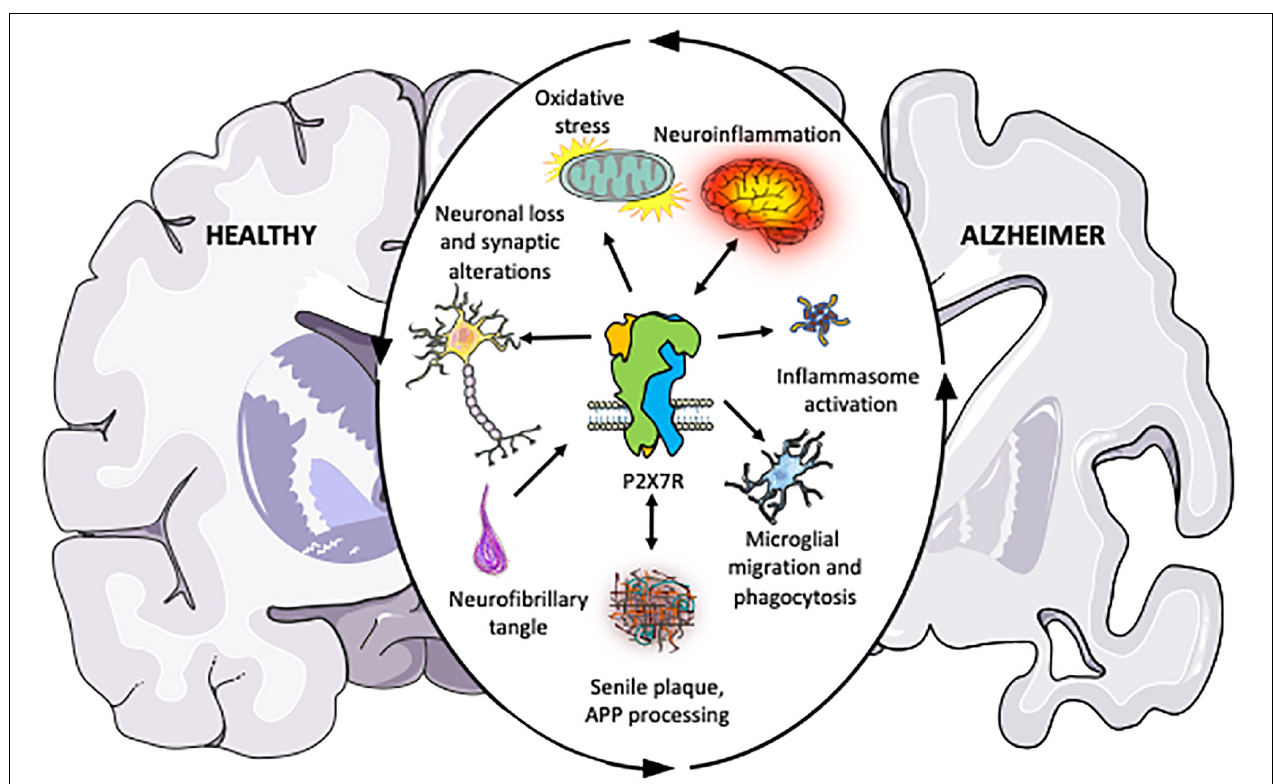
FIGURE 1 | Schematic illustration summarizing the pieces of evidence accumulated over the past years indicating that P2X7R plays a central role in the different physiopathological processes associated with Alzheimer’s disease. The outer circular arrows illustrate a chain of interconnected and mutually influenced pathological processes associated with AD. Inner arrows represent the relationships found between P2X7R and these pathological processes, summarizing the studies discussed in the present review. Briefly, P2X7R modulates amyloid APP processing, and it is postulated as a neuroinflammation triggering factor. Upregulated P2X7R expression in AD patients and different AD and neuroinflammation mouse models give it a key role in disease progression. Besides, P2X7R also contributes to neuronal loss and synaptic alterations, oxidative stress; inflammasome assembling; and altered microglial function, being all of them processes contributing to AD progression, as described in the present